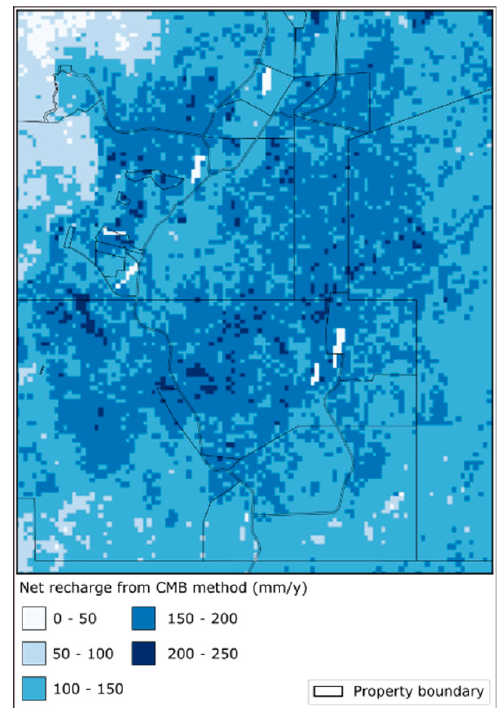
Figure A1. Estimates of net recharge based on the chloride mass balance (CMB) method [49].